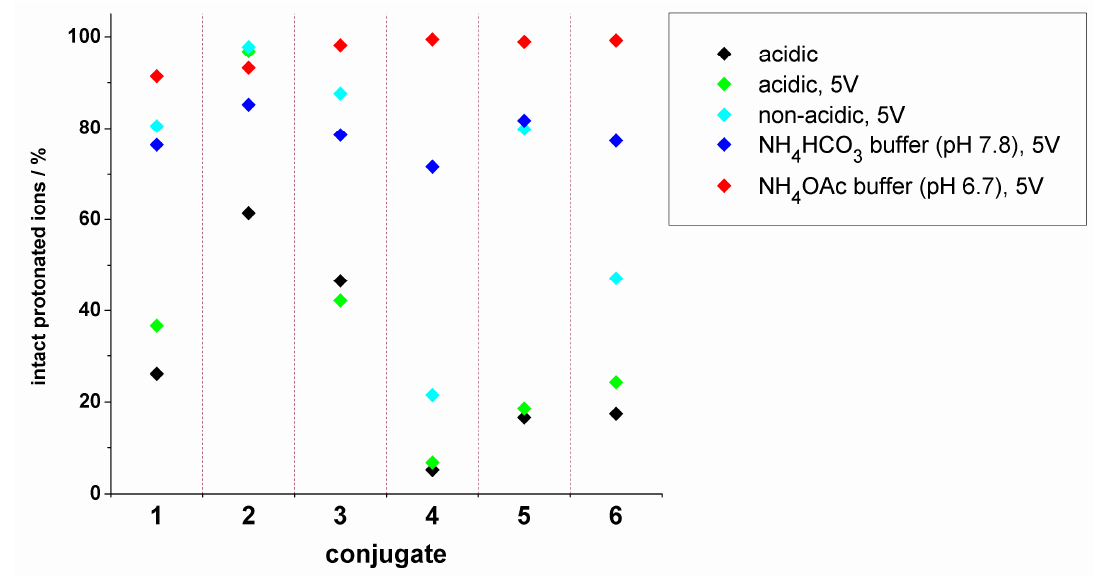
Figure 4. The intensity of the intact protonated ions (%) in the case of novel tuftsin-daunomycin conjugates under various conditions. The capillary exit potential, the solvents, and the pH were modified systematically.